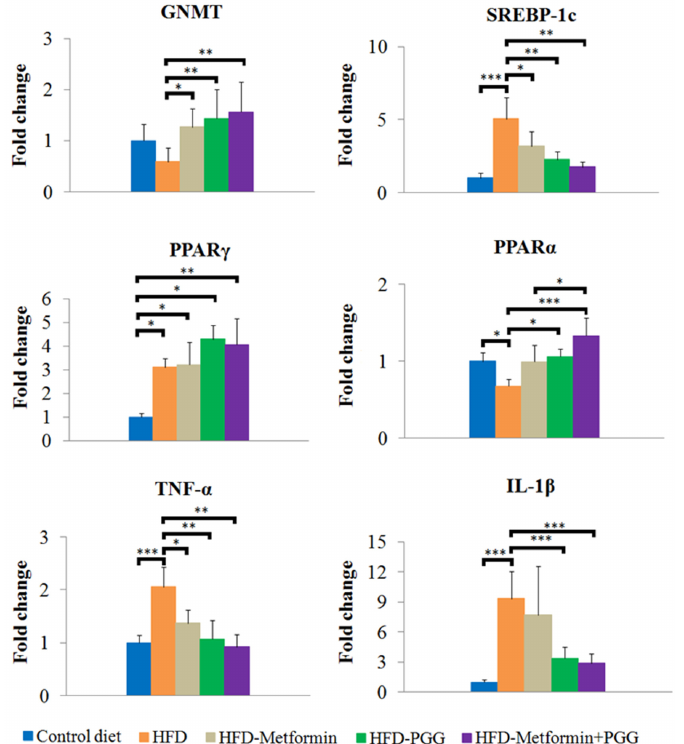
Figure 4. Analysis of mRNA expression for GNMT, SREBP-1c, PPAR α , PPAR γ , TNF α and IL-1 β in the liver tissue by RT-qPCR. (* p < 0.05; ** p < 0.01; *** p < 0.001; N = 8/group). 2.5. Combination of PGG and Metformin Reduced Hepatic Steatosis and Reversed the Inhibition of GNMT The results obtained from pathologic examination implied that PGG and metformin regulate lipid homeostasis in the liver. Therefore, specific genes related to lipid regulation were further elucidated by quantitative RT-PCR. SREBP-1c is a pro-lipogenic transcription factor that regulates the expression of genes involved in lipid synthesis. Another tran- scription factor is peroxisome proliferator-activated receptor gamma (PPAR γ ) [27,28]. HFD significantly stimulated expression of SREBP-1c and PPAR γ . PGG or metformin downregulated expression of SREBP-1c but significant reduction was only observed in the group of combination treatment. Inhibitory effects of HFD-induced PPAR γ expression were not observed in all the treatment groups. PPAR α is responsible for β -oxidation of fatty acid in the liver [29]. Downregulated β -oxidation in NAFLD subjects leads to fatty acid accumulation in the liver, which ultimately induces ROS production and stimulates pro-inflammatory effects [30]. In this study, PPAR α was decreased upon HFD administra- tion, which was reversed significantly by PGG and combination treatment. Combination treatment inhibited the expression of HFD-stimulated specific pro-inflammatory cyto- kines including TNF α and IL-1 β (Figure 4). These results suggested that combination of